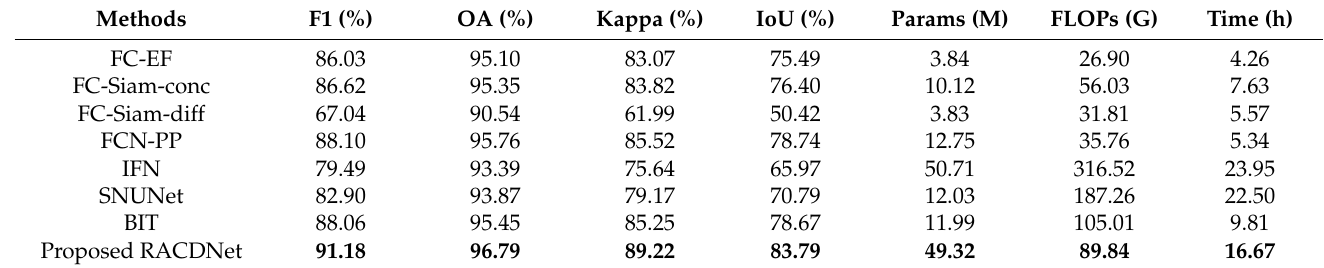
Figure 10. Visual comparisons of CD results for different methods. ( a ) Super-resolved Image T1. ( b ) Image T2. ( c ) FC-EF. ( d ) FC-Siam-conc. ( e ) FC-Siam-diff. ( f ) FCN-PP. ( g ) IFN. ( h ) SNUNet. ( i ) BIT. ( j ) RACDNet. ( k ) GT. Table 2. Quantitative comparisons of different CD methods. The best values are in